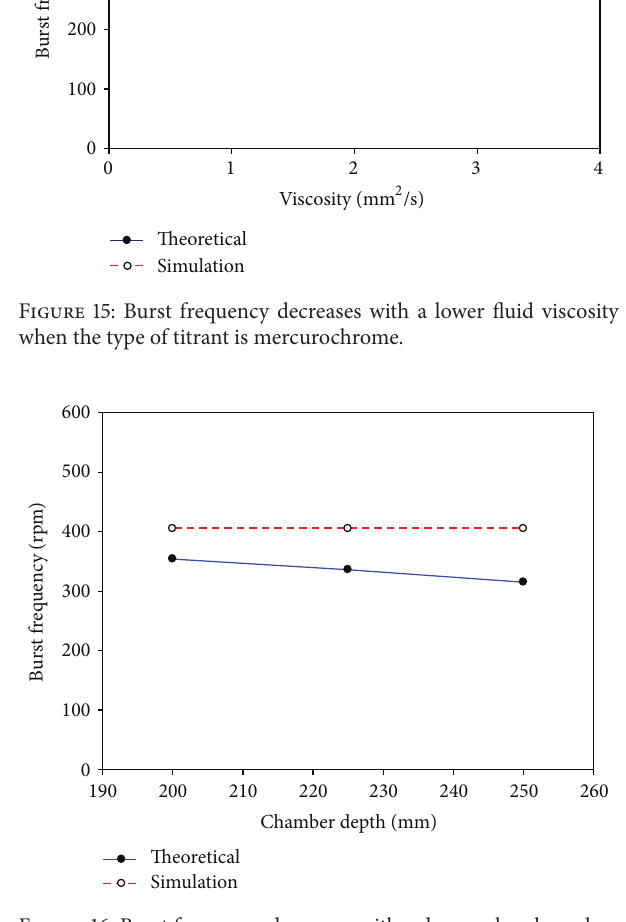
Figure 16: Burst frequency decreases with a deeper chamber when the type of titrant is